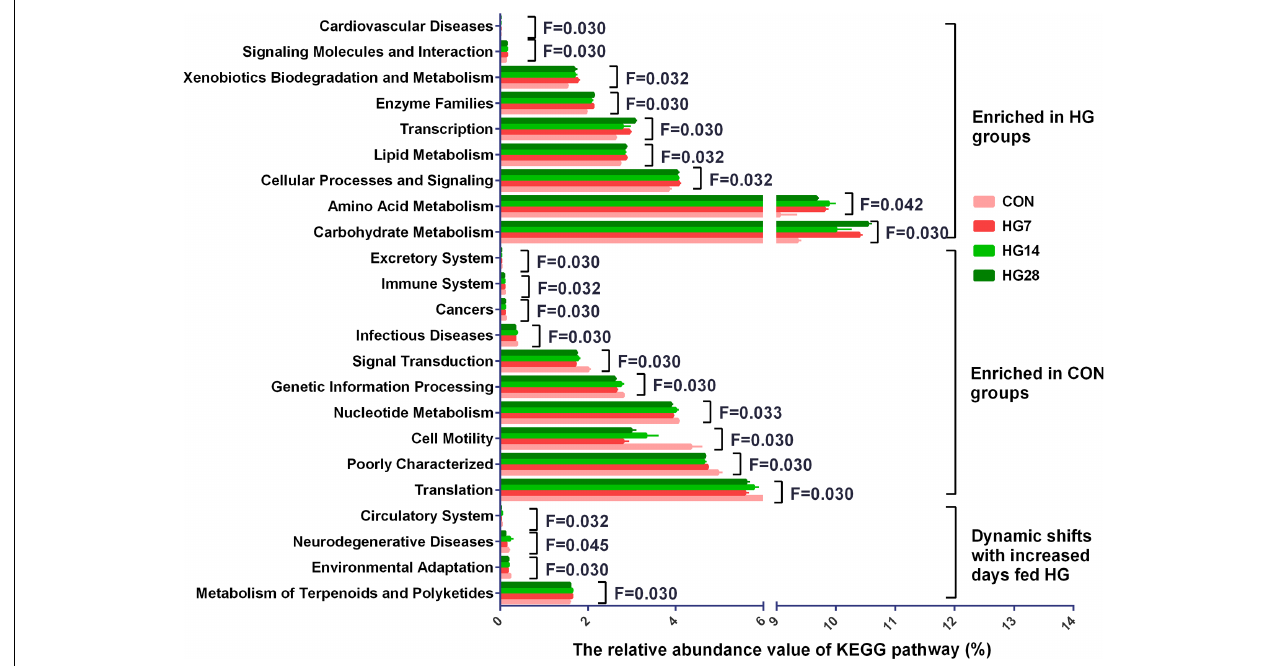
FIGURE 2 | Influence of feeding a high grain (HG) diet on the abundance of KEGG pathways of colonic mucosal microbiota of sheep. Only the KEGG pathways that were significantly affected in percentage with increasing number of days of being fed an HG diet were presented. Significance was declared at FDR <